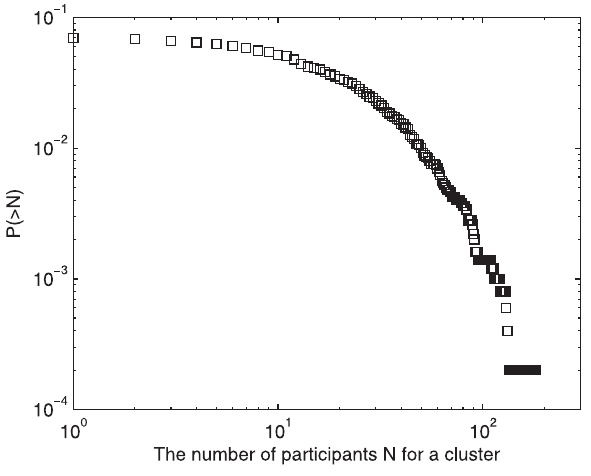
Figure 7. Cumulative distribution of the number of partici- pants for each cluster after 200 time steps, N ~ 5000 , l ~ 0 : 001 , and d ~ 0 : 5 . This curve decays more and more rapidly in the double logarithmic coordinates. This distribution coincides with the Tianya BBS in Fig. 2.